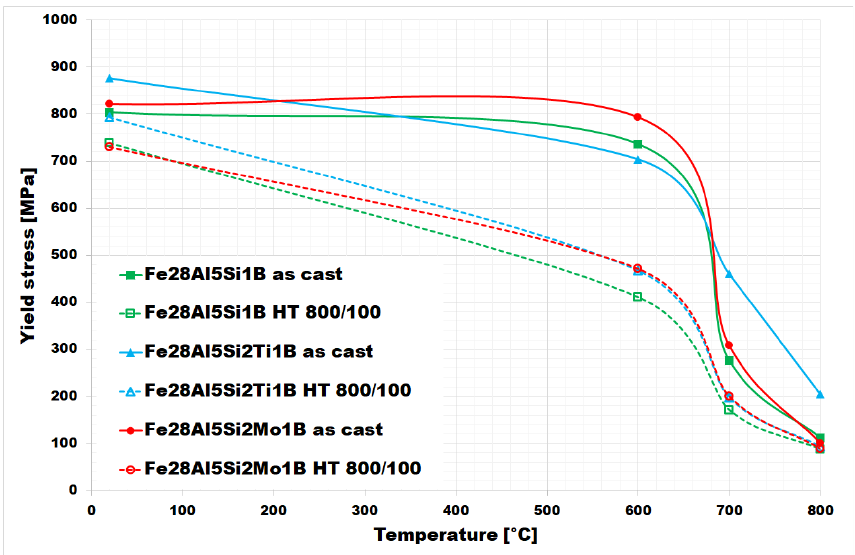
Figure 11. The values of the high – temperature yield stress of investigated alloys (as-cast states and also annealed states). also annealed